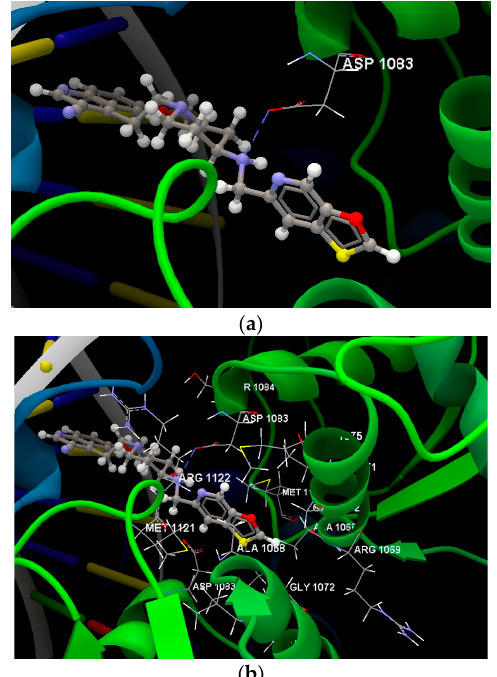
Figure 5. ( a ) The hydrogen bond between the amino acid residue of the ASP 1083(B) and the co-crystallized was displayed in dashed lines. ( b ) Docking pose of the co-crystallized ligand interacting with amino acids residues.